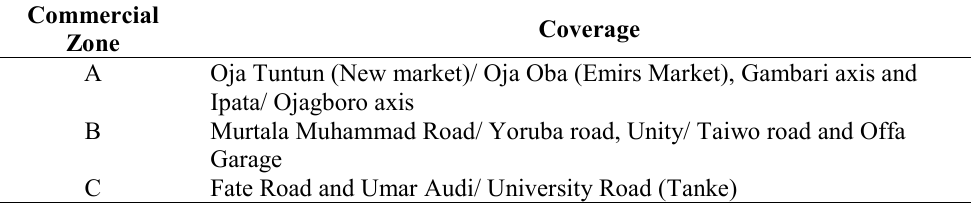
Table 1. Composition of Commercial Zones under